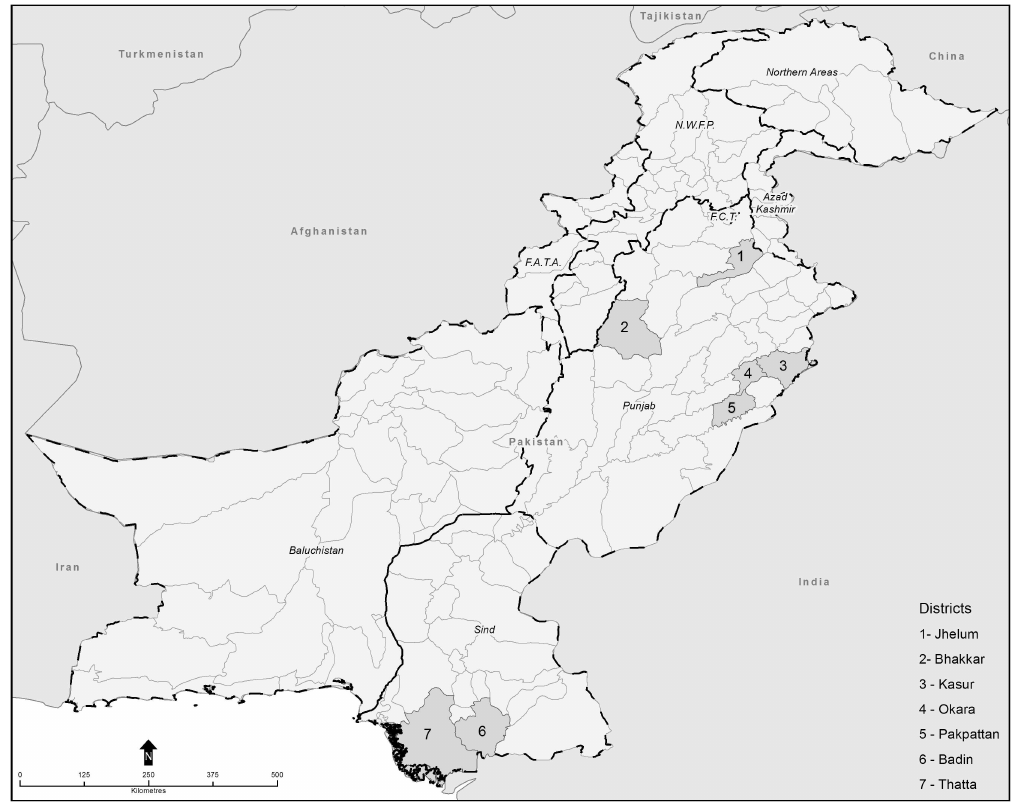
Fig 1. Map of Pakistan indicating current study areas(Map was createdusing ArcGIS ® software by Esri. ArcGIS ® and ArcMap ™ )